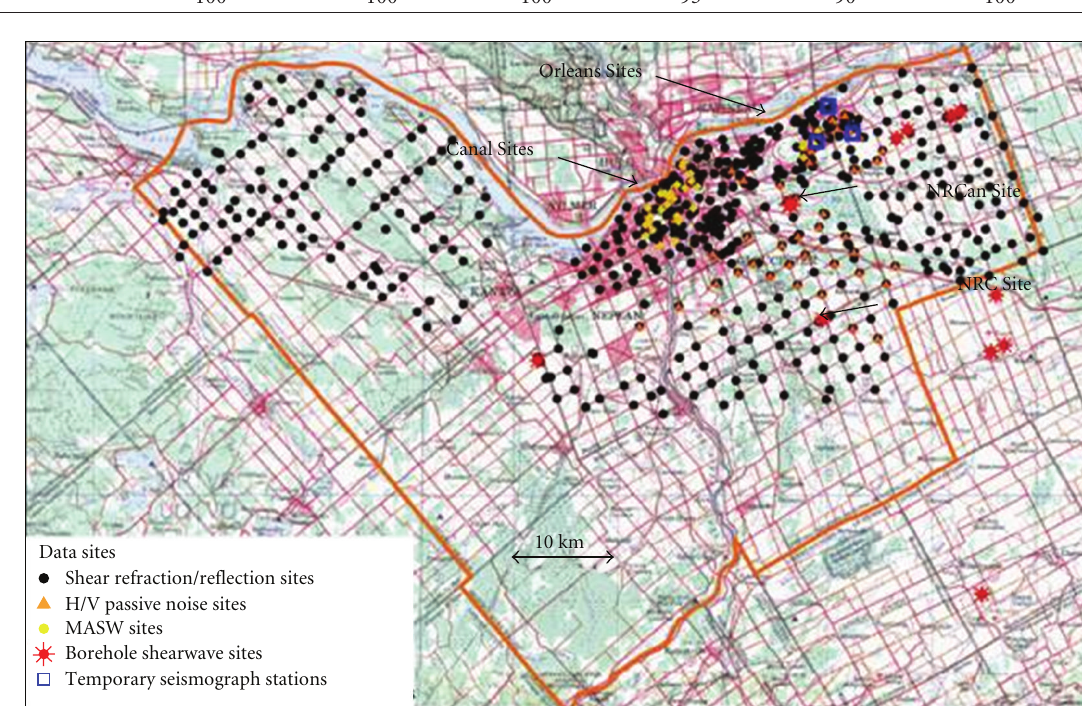
Figure 1: City of Ottawa and the research